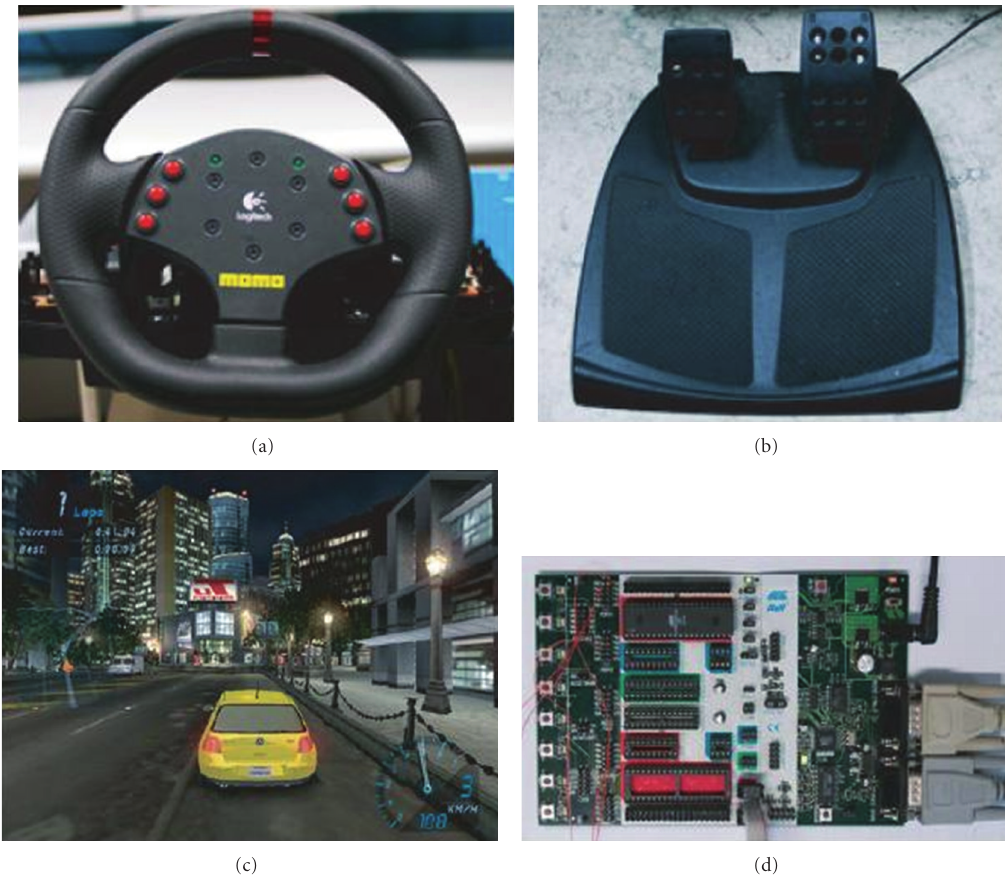
Figure 4: (a) Steering wheel; (b) Acceleration and brake pedals; (c) Simulated driving scene; (d) Processor circuit